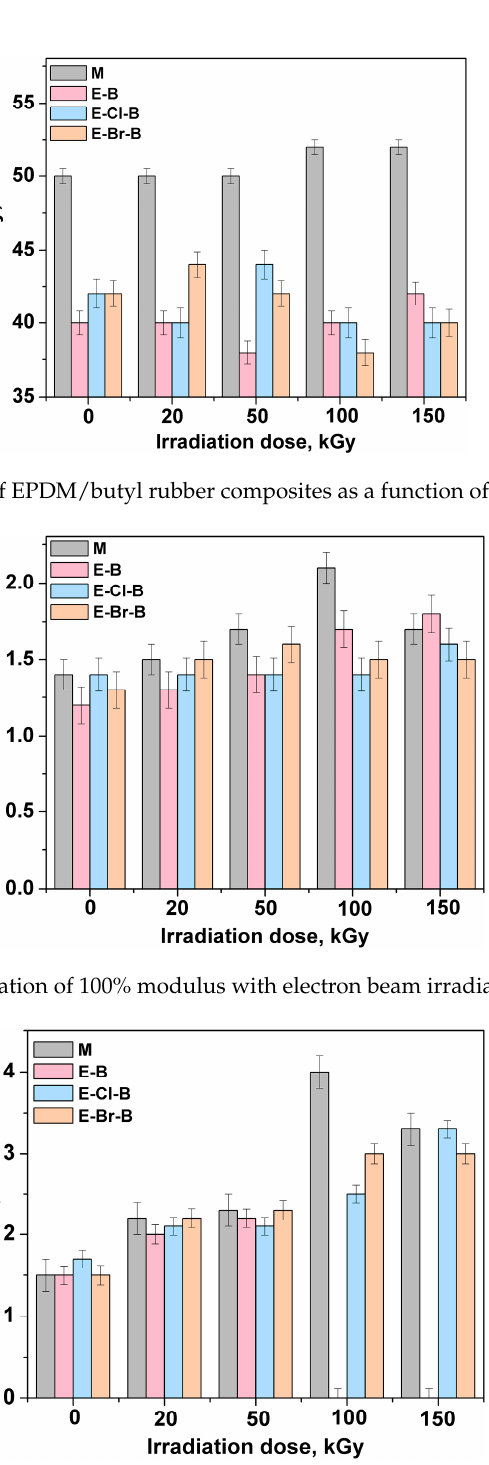
Figure 4. Variation of 300% modulus of EPDM/butyl rubber composites with irradiation dose.